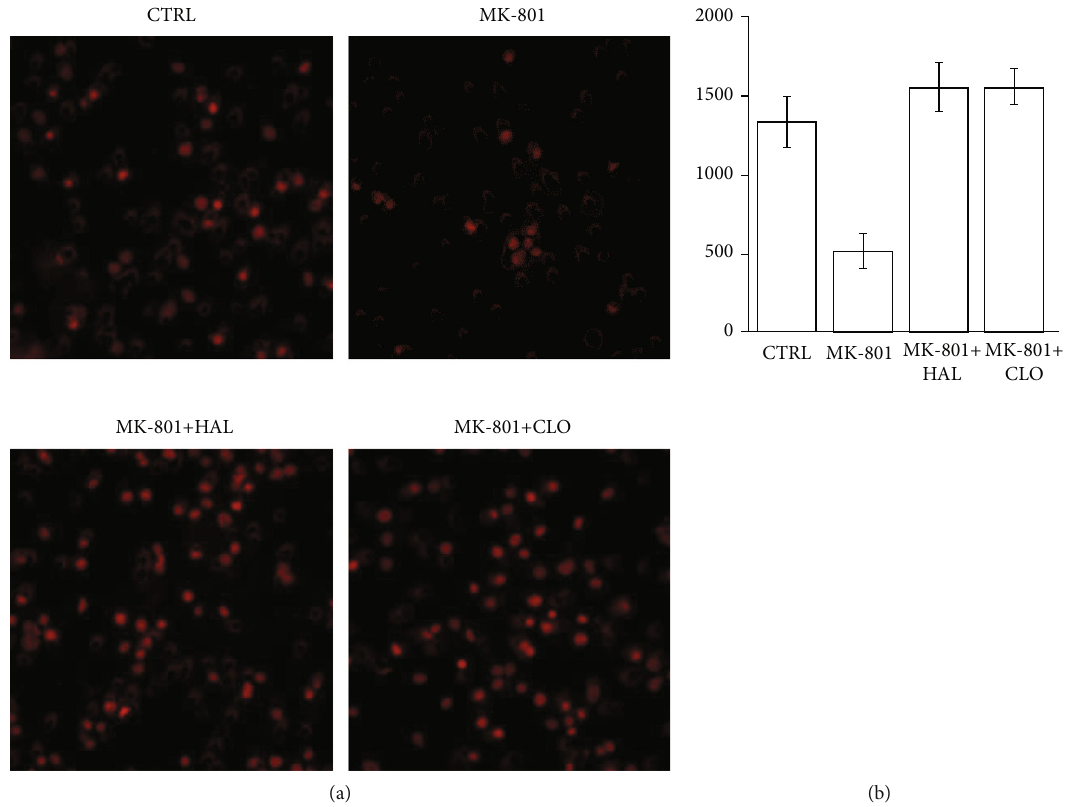
Figure 4: E ff ects of MK801, haloperidol (HAL), and clozapine (CLO) on the cell migration ability of B35 cells. (a) Cell migration was analyzed, and the cell numbers were counted after staining. (b) The bar chart was constructed from triplicate cell count data obtained from three di ff erent batches of MK801/APD-treated cells and analyzed using ANOVA followed by Dunnett ’ s test ( ∗ p value < 0.05; ∗∗ p value <